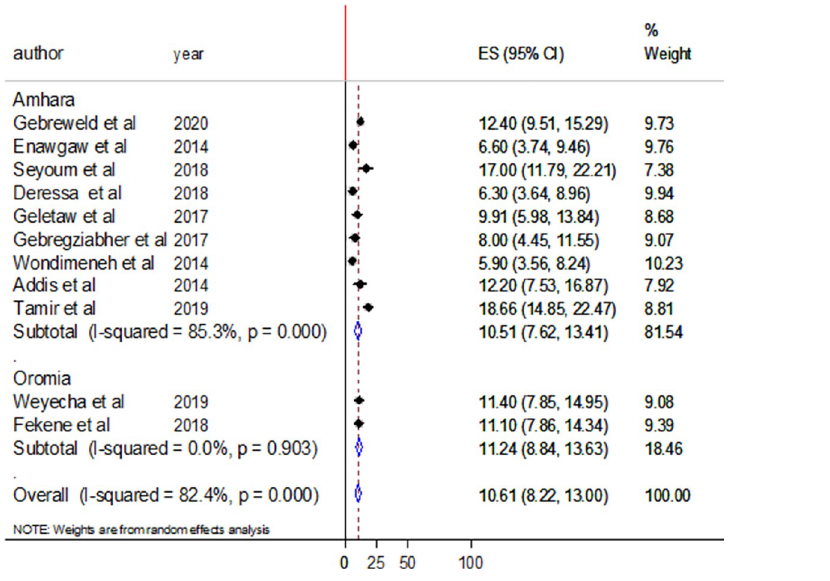
Fig 5. Forest plot showing subgroup analysis by